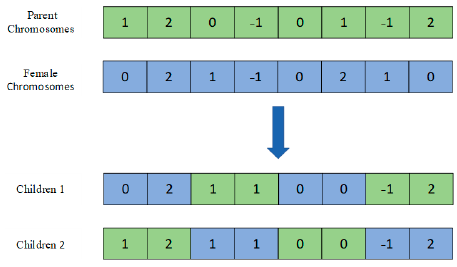
Figure 3. Uniform